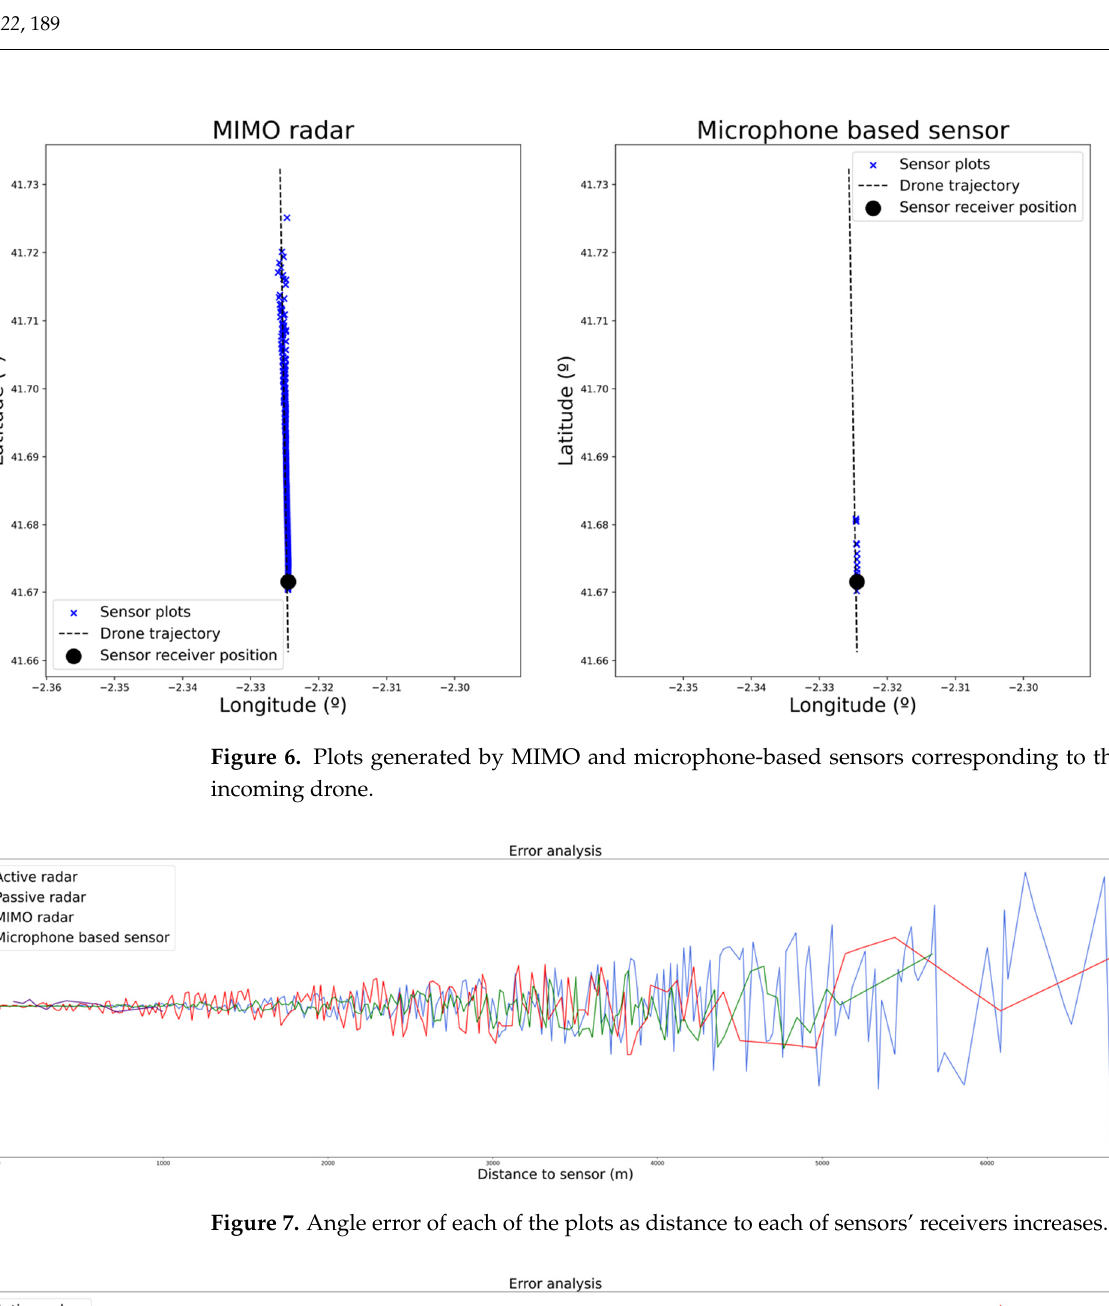
Figure 5. Plots generated by the active and passive radar sensors corresponding to the actual incoming drone.